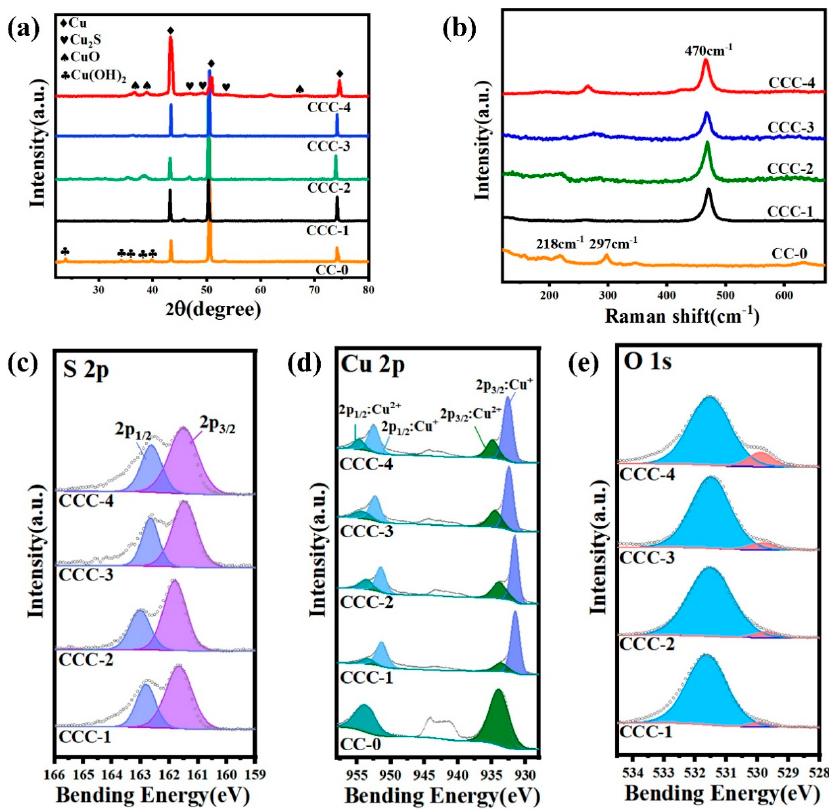
Figure 4. The optical absorbance of